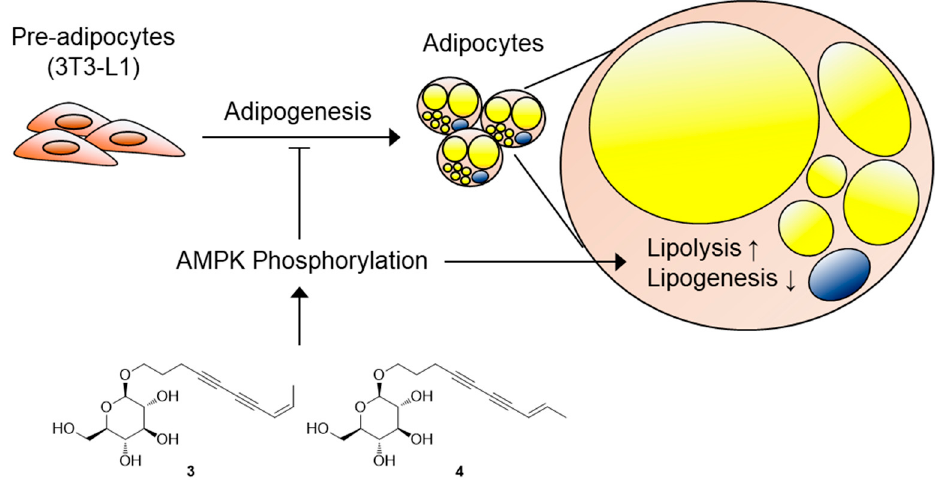
Figure 7. Molecular model explaining the mechanism of action of compounds 3 and 4 . Compounds 3 and 4 inhibited the adipogenesis of 3T3-L1 preadipocytes, induced AMP-activated protein kinase (AMPK) phosphorylation, and stimulated lipid metabolism through the enhancement of lipolysis and the suppression of lipogenesis.